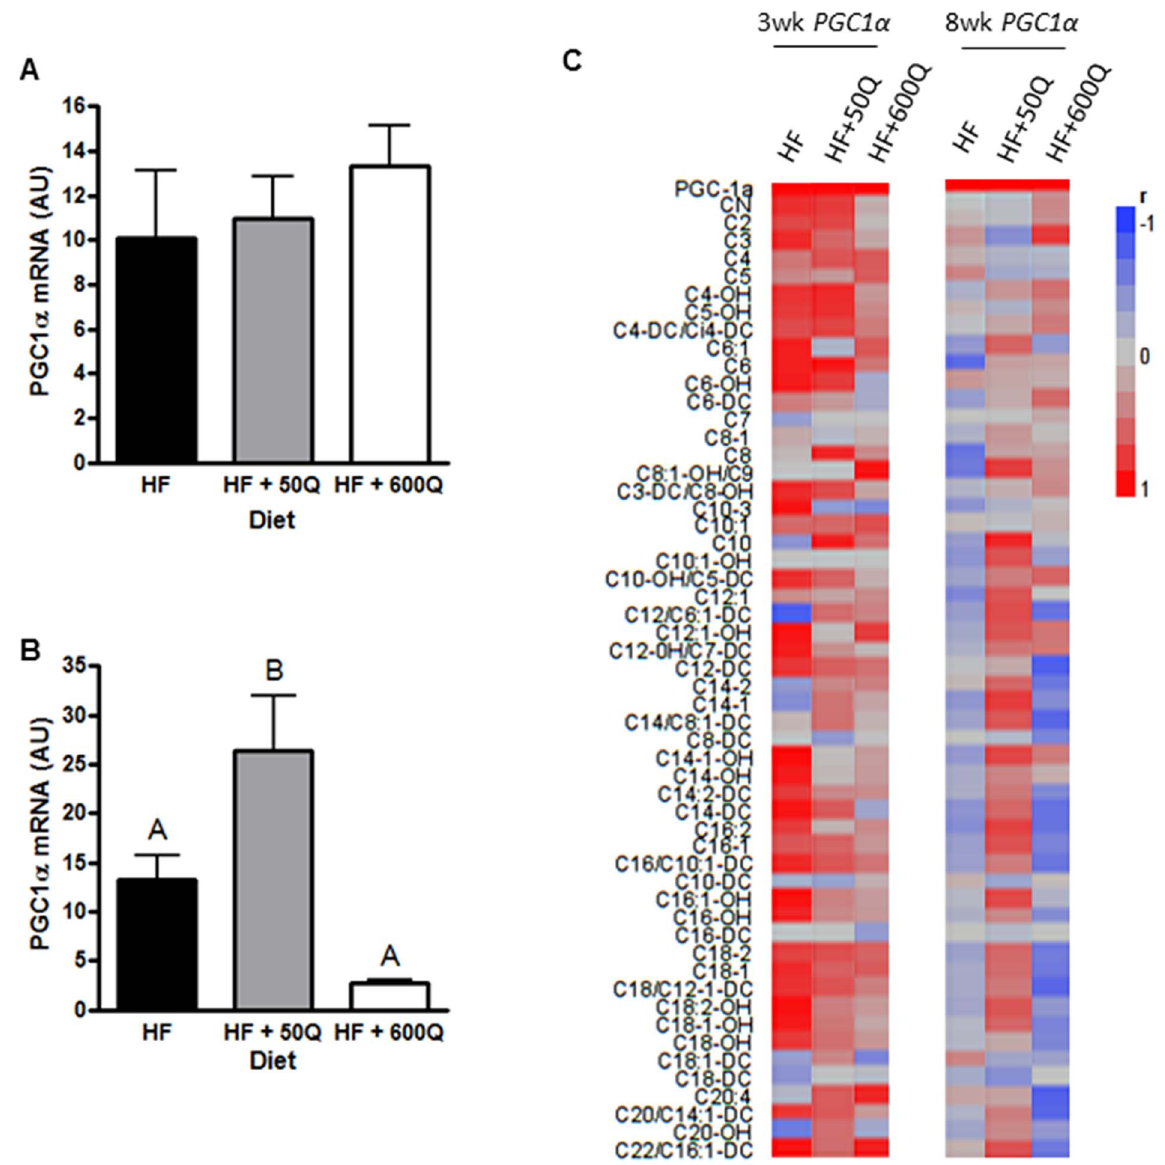
Figure 5. PGC1 a mRNA was quantified by qRT-PCR after 3wks (A) and 8wks (B) of feeding respective diets and is shown as means ± SEMs in arbitrary units (AU) for each group. Significant differences by Tukey post hoc are denoted by differing superscripts. ( C ) PGC1 a mRNA levels were correlated with acylcarnitine levels in each group after 3 and 8wks of feeding in HF, HF + 50Q or HF + 600Q. 2 1 correlations between gene expression and an acylcarnitine is represented by blue and + 1 correlations by